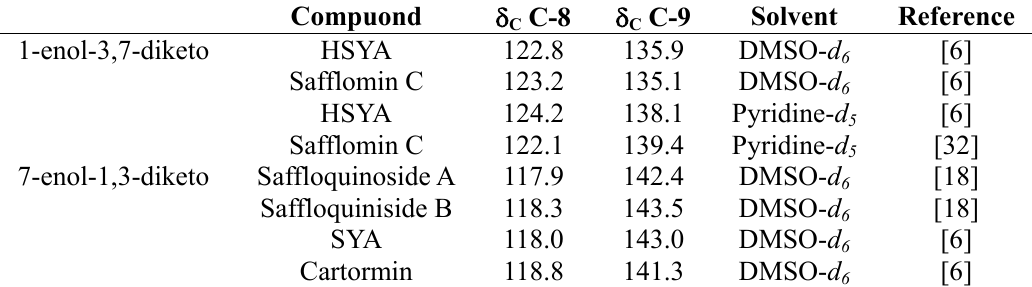
Table 11. 13 C-NMR data of the (E)-olefinic carbon of quinochalcone C -glycosides